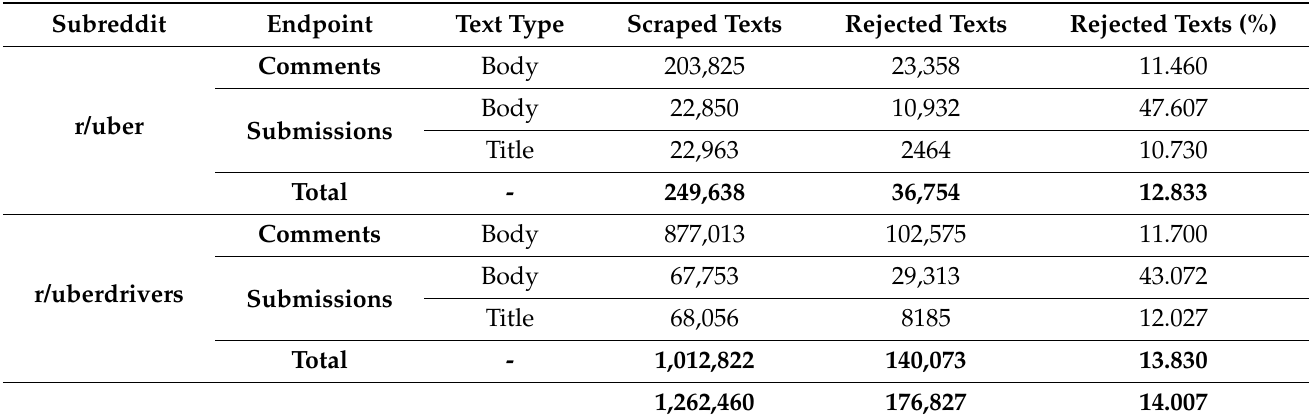
Figure 4. Evolution of the number of retrieved posts in r/uber and r/uberdrivers subreddits over time. Table 1. Data breakdown of r/uber and r/uberdrivers